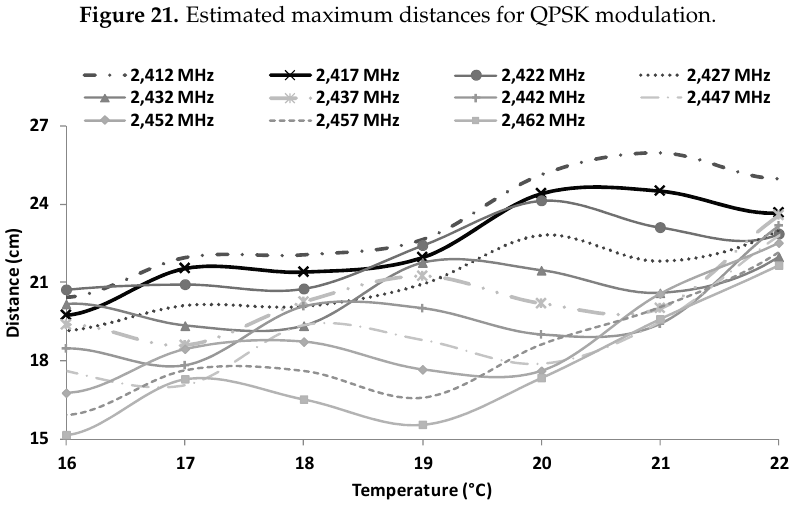
Figure 22. Estimated maximum distances for OFDM modulation.